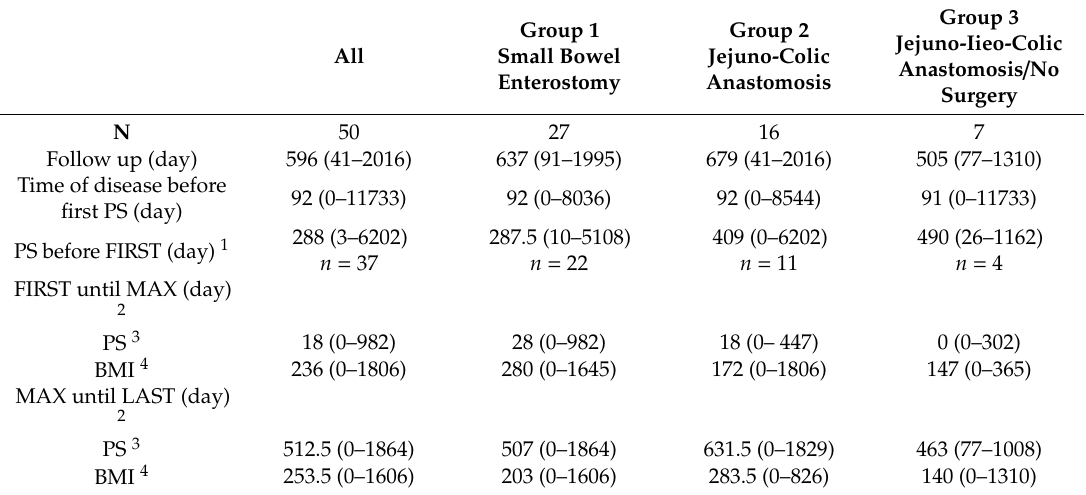
Table 3. Time course as assessed by FIRST, MAX, and LAST. Median